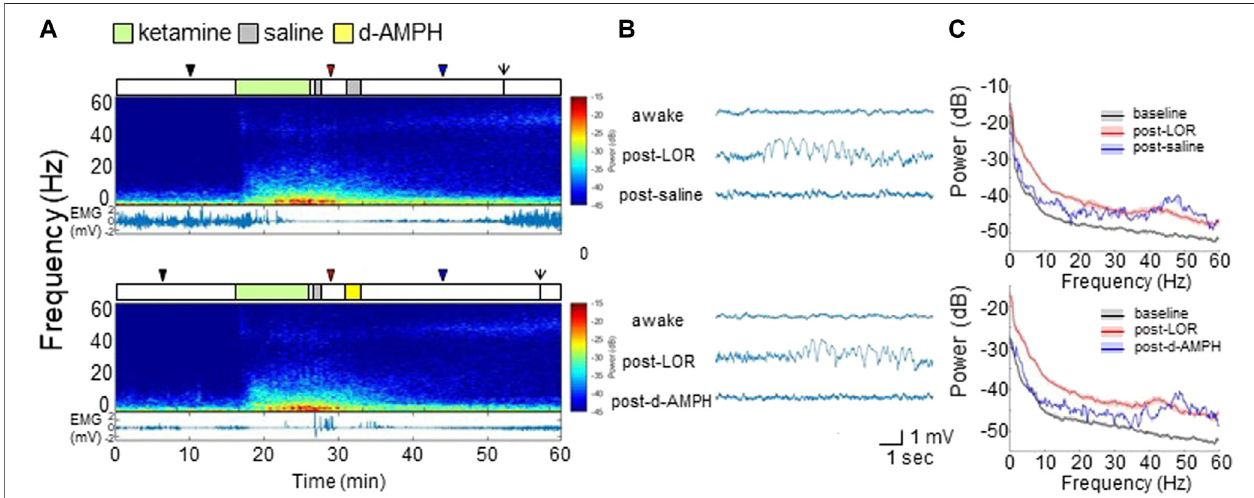
FIGURE 4 | D - amphetamine does not appreciably alter the spectral content of PFC LFP recordings after ketamine. (A) Experimental time courses, spectrograms, andEMGrecordingsfromarepresentativerat.ThearrowsindicateROR. (B) RawLFPwaveformsfromeachtimeperiod. (C) Themedianand95%CIofspectraldensity during awake (black), post-LOR (red), and 10 min after saline or d-amphetamine